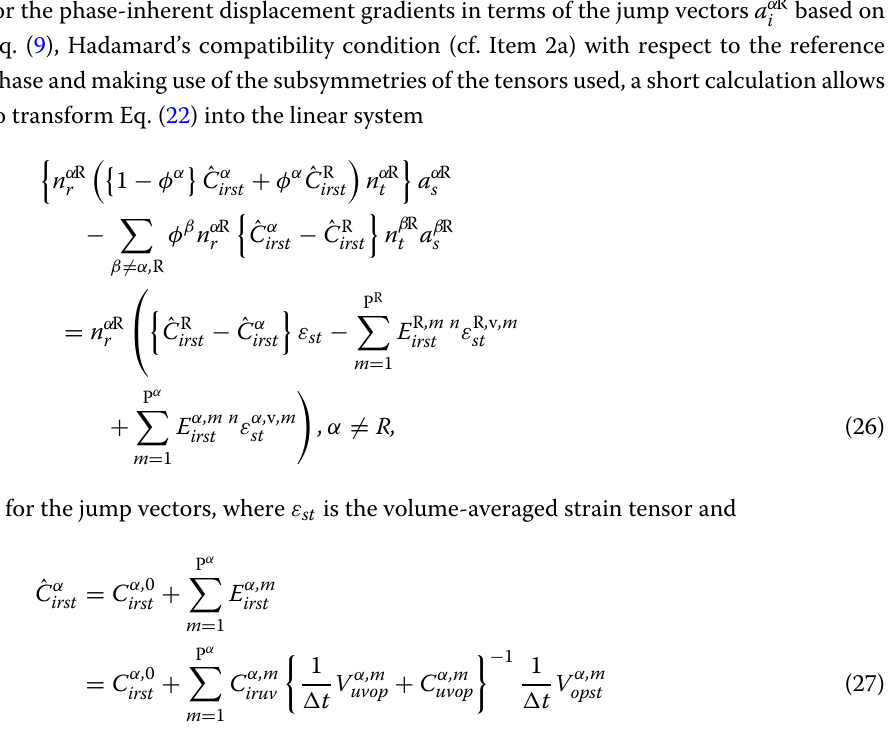
isthe algorithmicallyconsistent phase-inherenteffectivestiffnesstensor(intermsof (cid:14) t